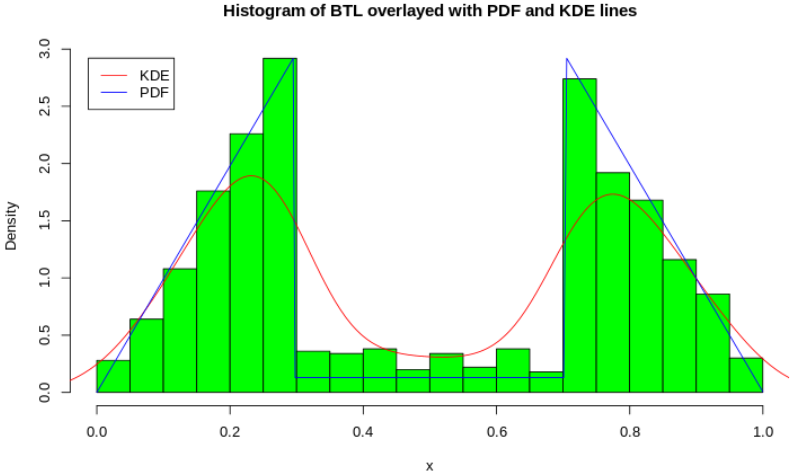
Figure 3. Histogram and Density plots of BT L Distribution with θ 1 = 0.3, θ 2 = 0.8, α 1 = α 2 = 3.